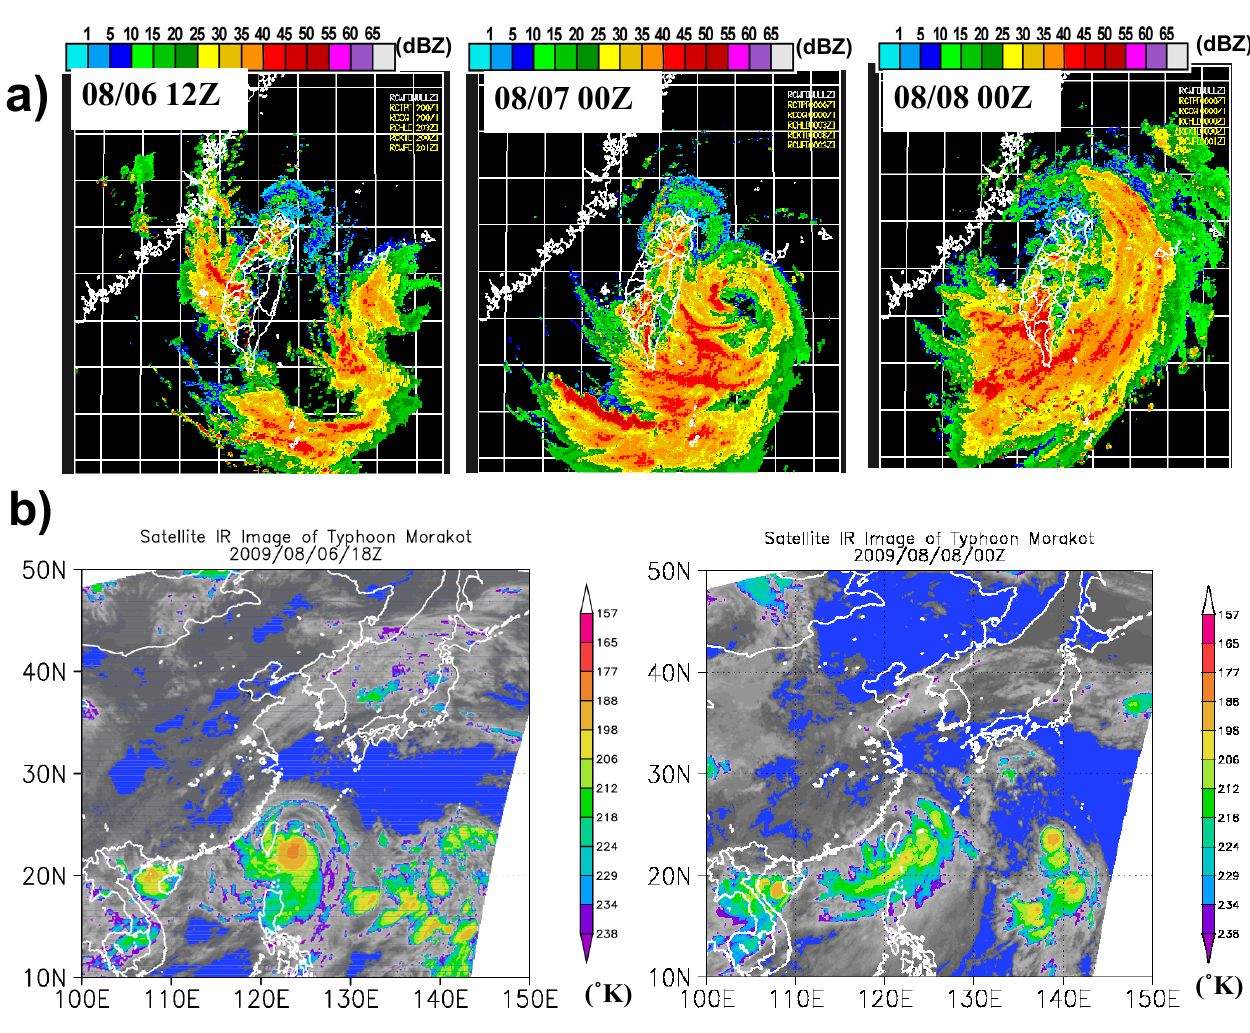
Fig. 2. (a) Composite of the maximum radar reflectivity in a volume (colored) at 12:00UTC 6, 00:00UTC 7 and 00:00UTC 8 August, 2009. (b) Infrared Satellite image from Japan MTSAT satellite at 18:00UTC 06 and 00:00UTC 8 August 2009. The colored areas represent cold brightness temperatures ( ◦